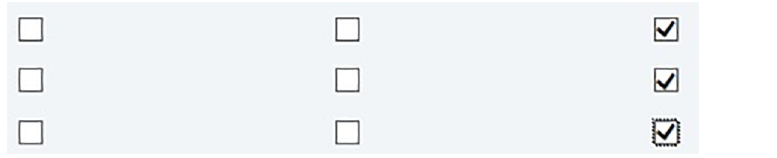
Fig 2. Example of a check marks pattern in the low-load condition.